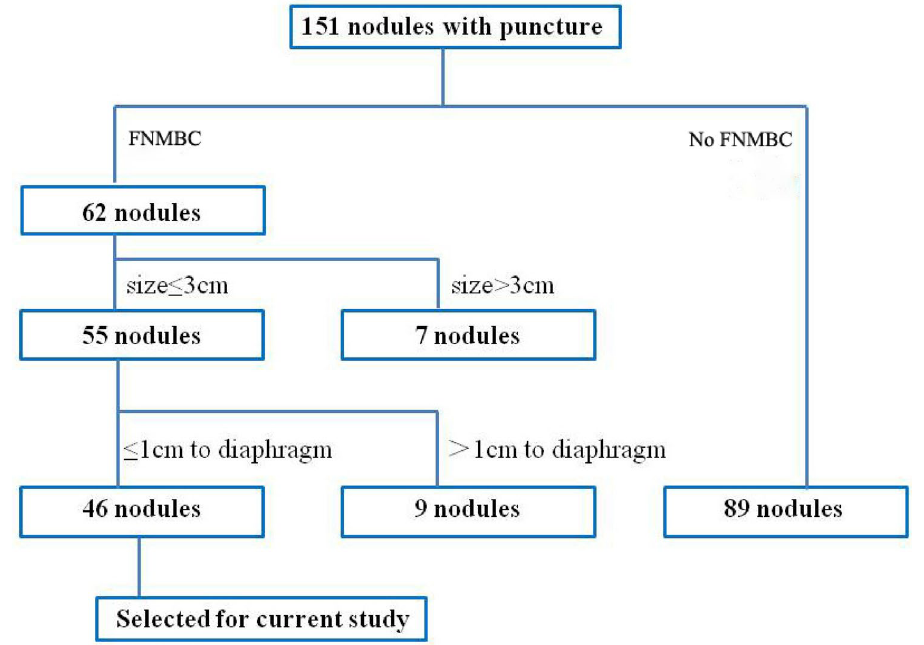
Figure 1. Flow chart of patient selection for this study. FNMBC: Fine needle-mediated breathing